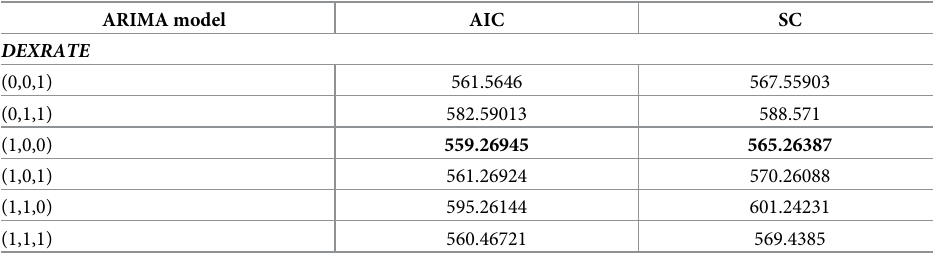
Table 3. Feasible ARIMA models.